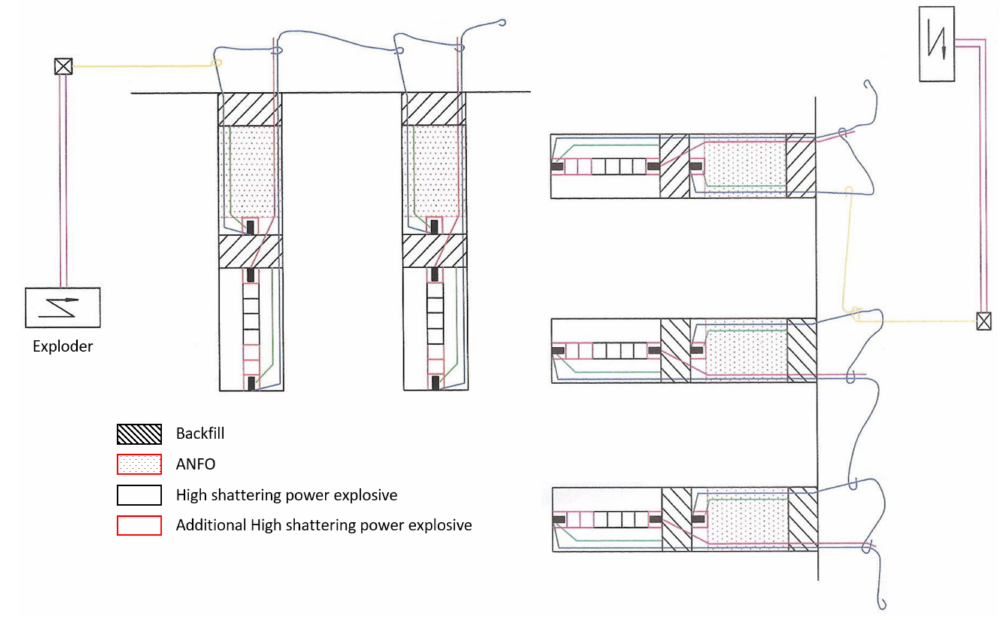
Figure 6. Side connection ( left ) and central connection ( right